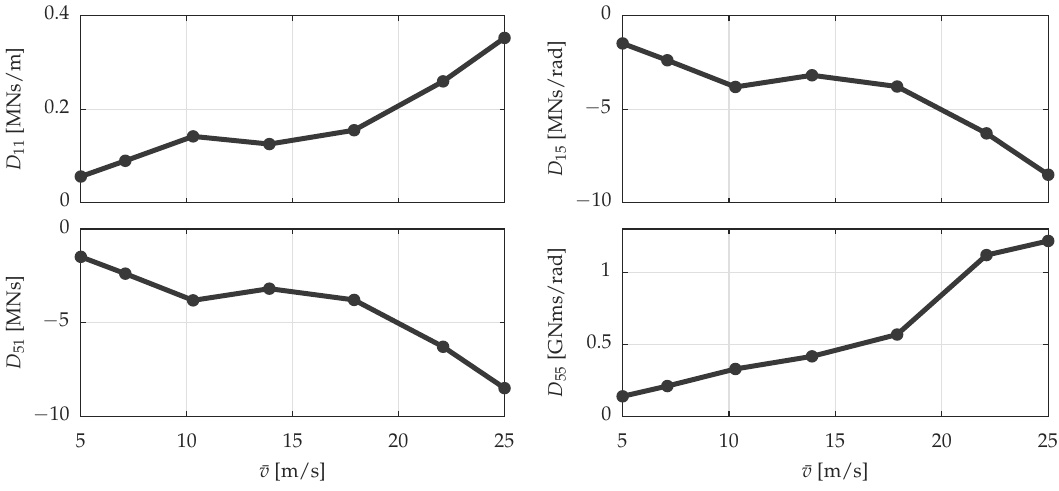
Figure 10. Global linearized Morison drag matrix elements for full-scale TripleSpar over environmental conditions of Table